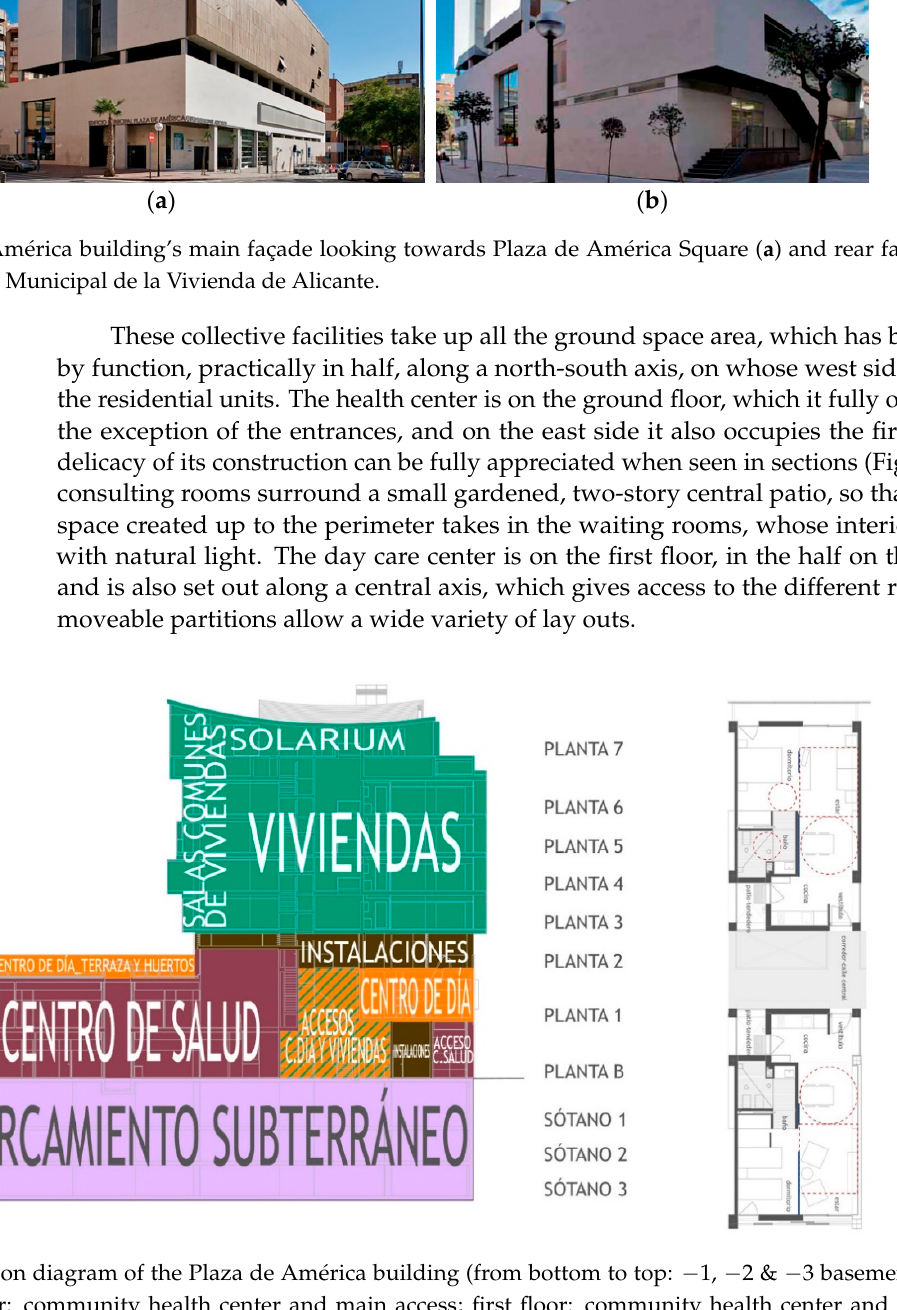
Figure 12. Plaza de América building’s main façade looking towards Plaza de América Square ( a ) and rear façade ( b ). Courtesy of Patronato Municipal de la Vivienda de Alicante.